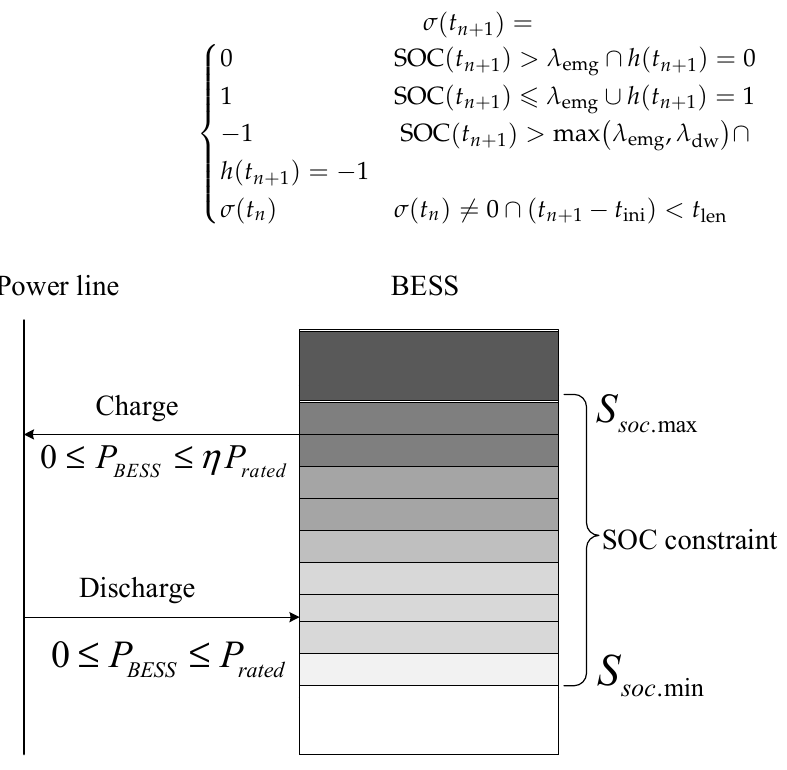
Figure 2. BESS system model diagram.